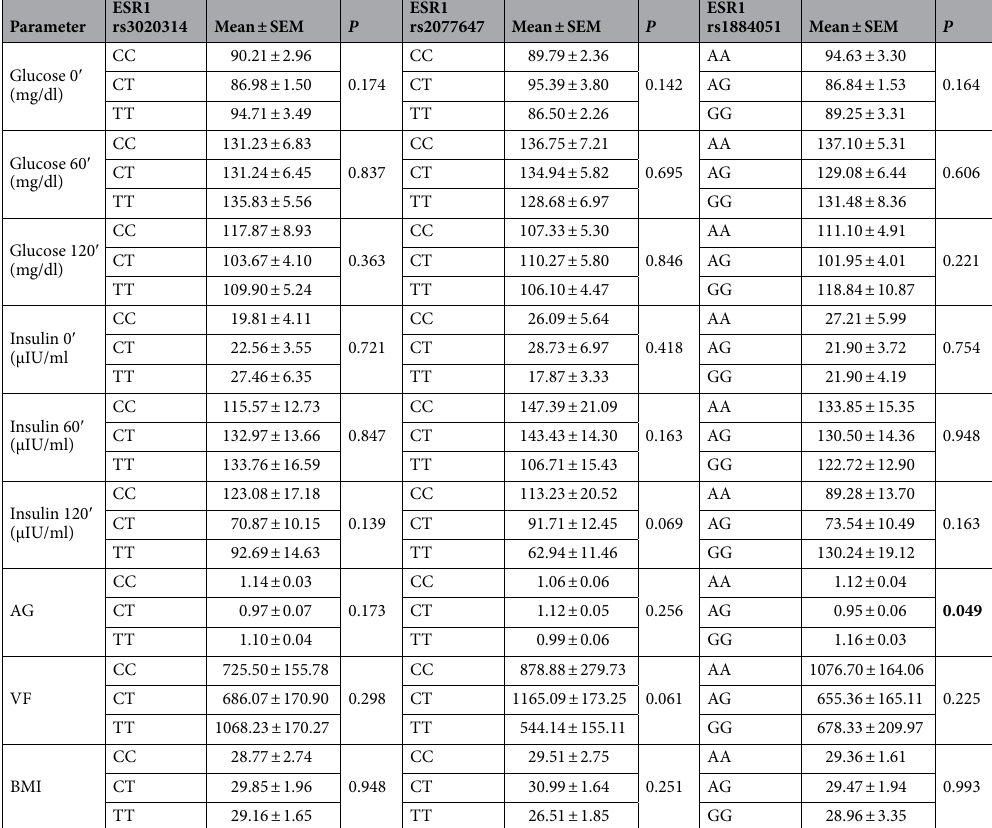
Table 5. Analysis of clinical parameters in relation to ESR1 gene polymorphisms in patients with hyperandrogenism. AG distribution of android and gynoid fat, VF visceral fat indication, BMI Body Mass Index. Significant values are given in